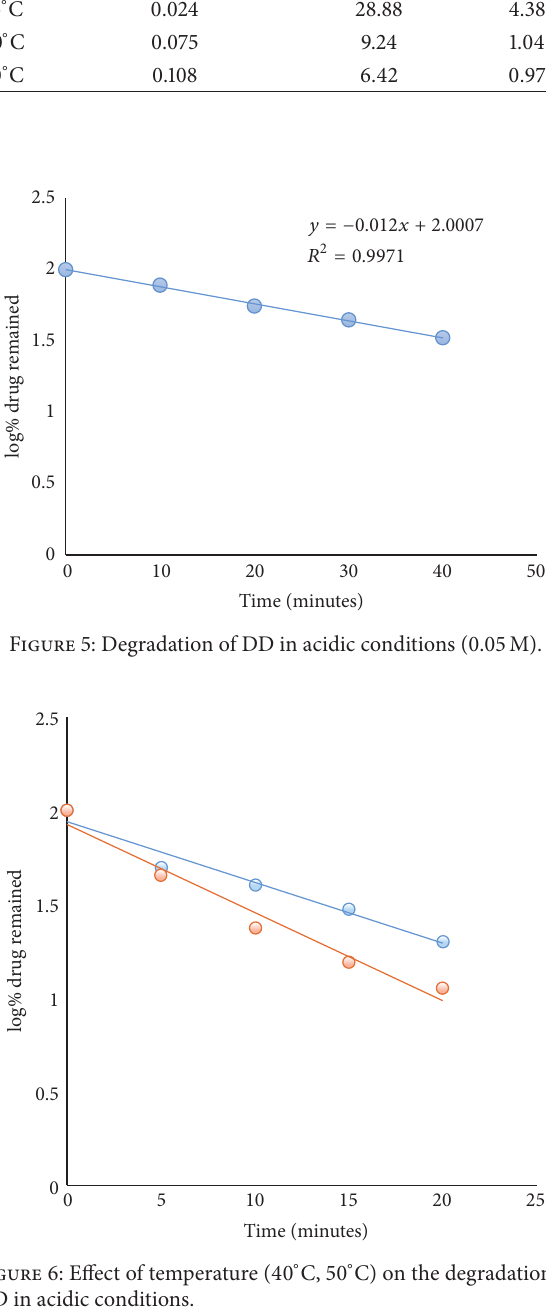
Table 3: Effect of temperature on DD degradation rate. Temp.